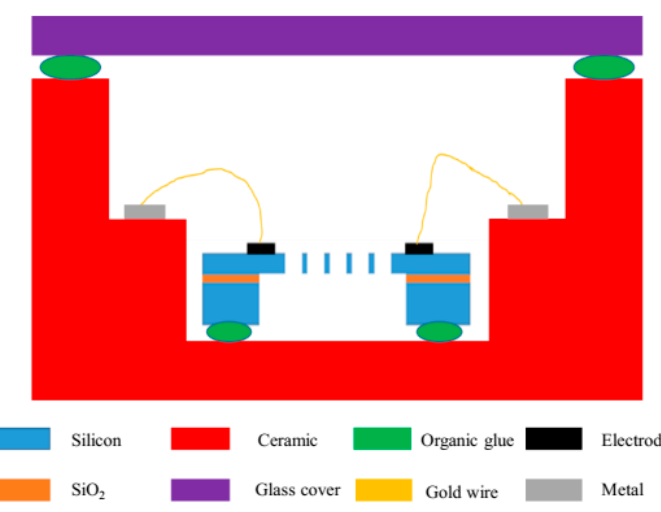
Figure 15. The structure of the package.